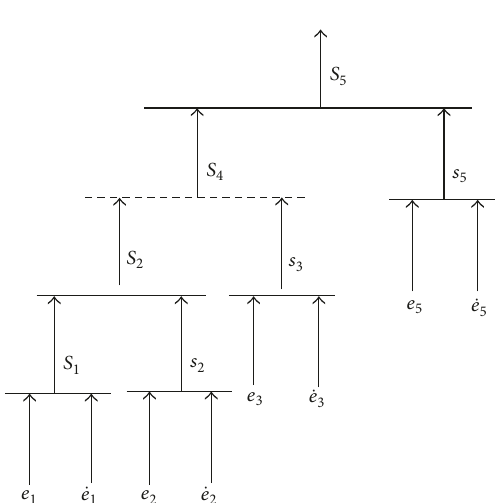
Figure 11: Hierarchical sliding surfaces structure for system which has one control input and five output variables.